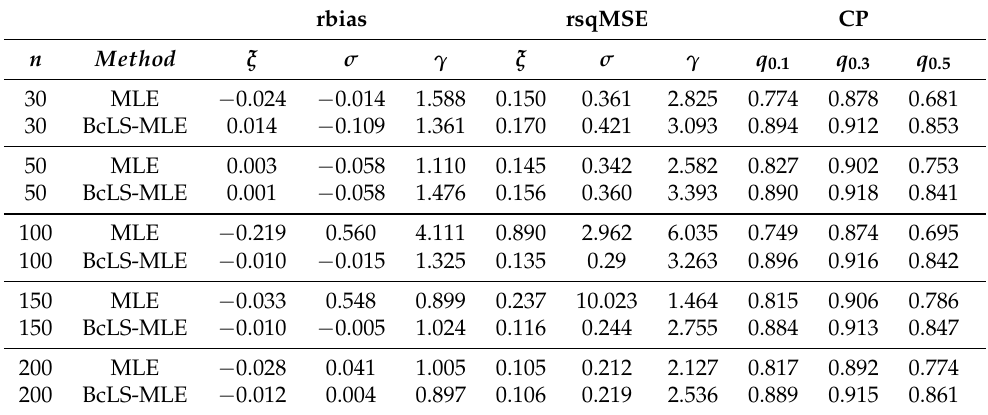
Table 5. The rbias and rsqMSEs of the BcLS-MLE and MLE, and the CP of S ( y 0 | Θ ) for LPN ( Θ ) with